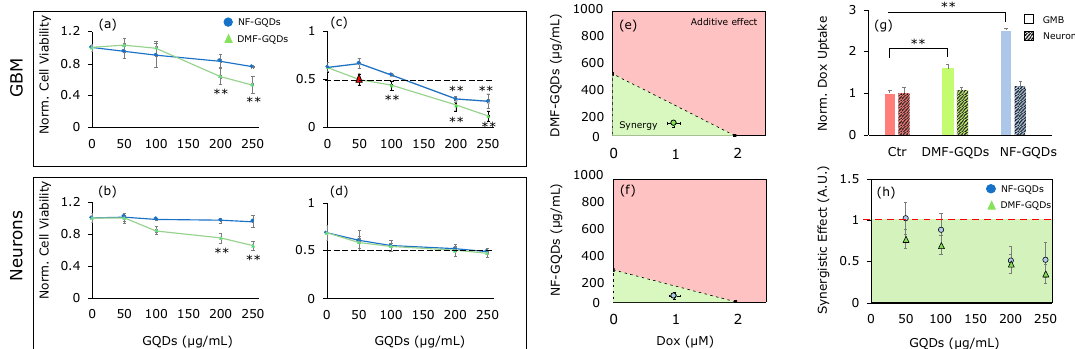
Figure 2. Biocompatibility and e ff ect of GQDs in enhanced chemotherapy. Cell viability of GQDs on glioblastoma multiforme (GBM) ( a ) and cortical neurons ( b ) normalized by untreated cells. Viability after GQDs enhanced chemotherapy on GBM ( c ) and cortical neurons ( d ). Isoboles of enhanced chemotherapy on GBM for DMF-GQDs ( e ) and NF-GQDs ( f ). Uptake of doxorubicin (Dox) in untreated GBM cells, and after the treatment with DMF and NF-GQDs ( g ). The synergy of Dox and GQDs at the tested concentrations on GBM and neurons ( h ). The data are expressed as the mean values normalized to the untreated cells ± standard deviation. Synergy is expressed as the ratio between the theoretical additive e ff ect of the two molecules and the combined measured e ff ect. ** p < 0.01, one-way ANOVA and Turkey post-hoc test.